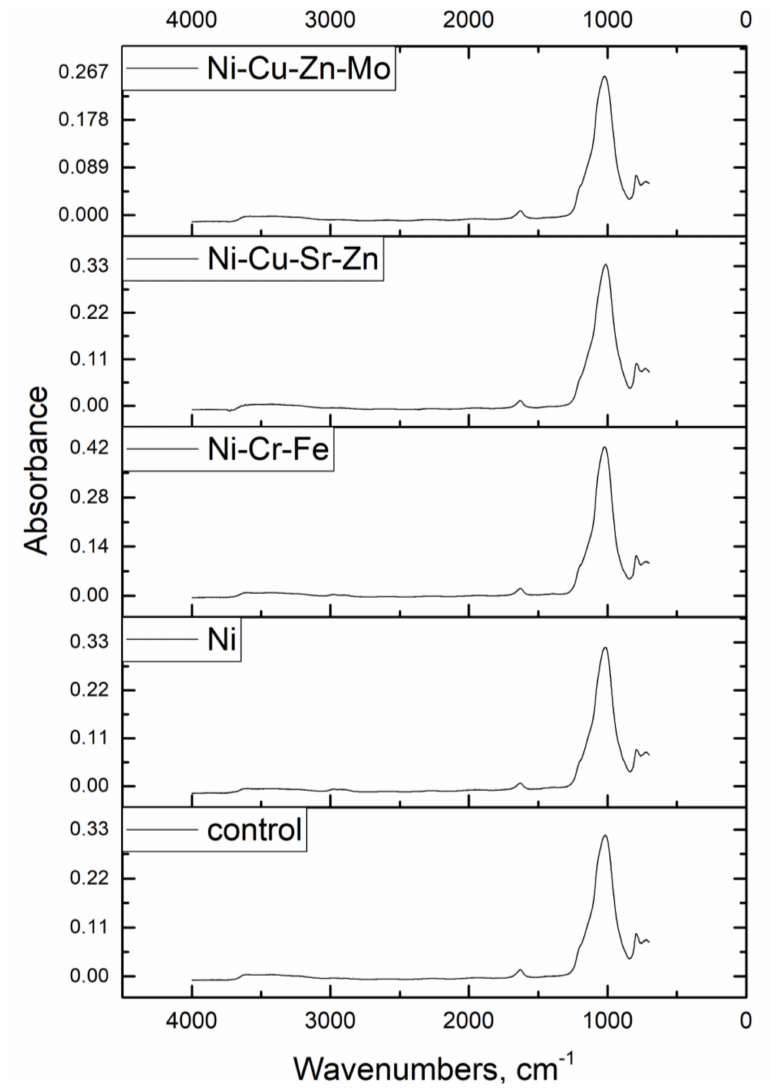
Figure 3. FTIR spectra of control and metal-loaded hybrid